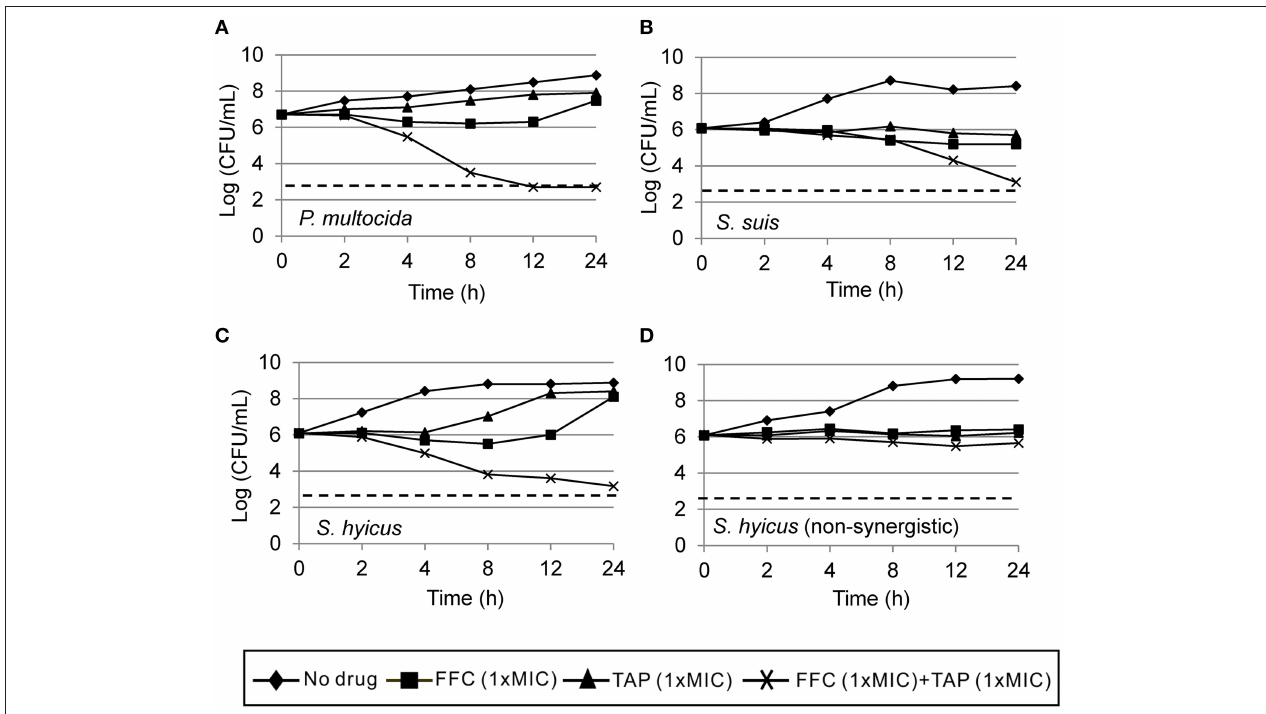
FIGURE 2 | Time-kill curves of combinations of florfenicol (FFC) and thiamphenicol (TAP) against (A) P. multocida (101-035), (B) S. suis (CY13005-1L), (C) S. hyicus (CM134-2), and (D) a non-synergistic strain, S. hyicus (CM144-1C) which serves as a negative control. Refer to Table 1 for strain MIC data. Each point represents the mean of duplicate determinations. The detection limit (dotted line) was 2.7 log 10 CFU/mL.